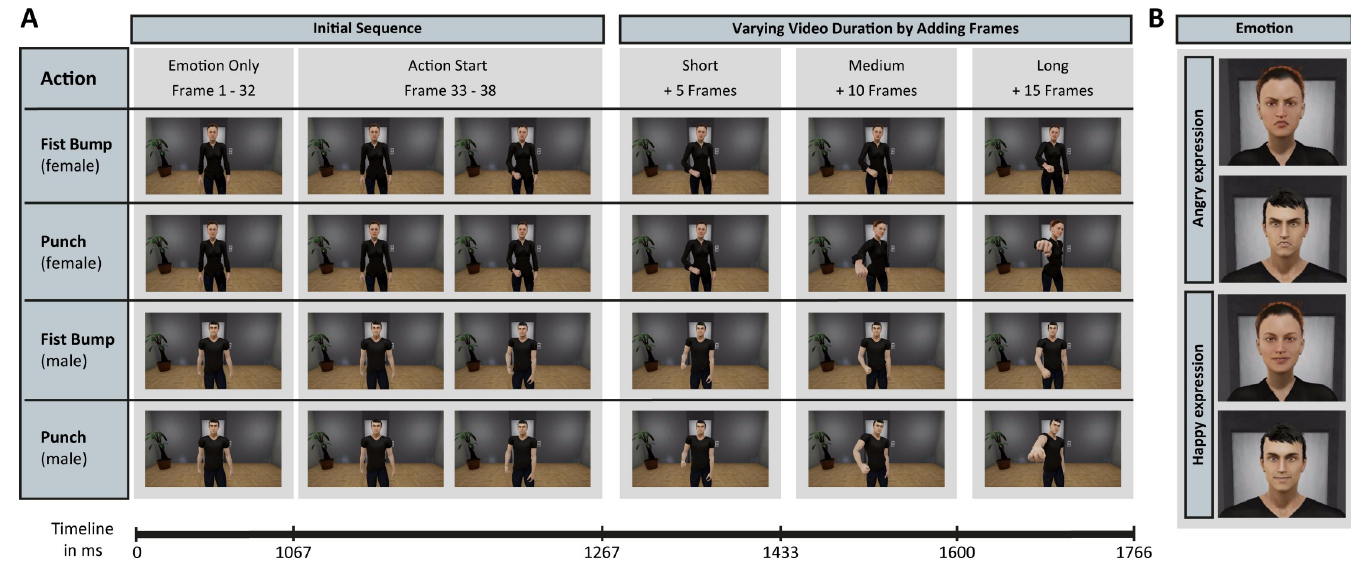
Fig 1. Schematic illustration of the video stimuli. (A) Each row depicts the timeline of an unfolding action (fist bump or punch), separately for the two agents (female and male). Two exemplary combinations of facial emotions and actions are shown per agent. The first three columns show the initial sequence that was presented in all video stimuli (frames 1–38). Agents displayed the facial emotion starting from the first frame (the facial emotion remained constant throughout the video clip). The initial sequence also included the onset of the action, from frame 33 to frame 38. From frame 39 onwards, single frames were added to the video clips in order to vary the degree of completeness to which an unfolding action was presented. Video duration was grouped according to the number of added frames, resulting in ‘short’ (1–5 frames added), ‘medium’ (6–10 frames added), and ‘long’ (11–15 frames added) video durations. (B) Illustration of the angry and happy facial emotions of both agents. Reprinted from https://www.daz3d.com/under a CC BY license, with permission from Daz Productions Inc, original copyright 2021.